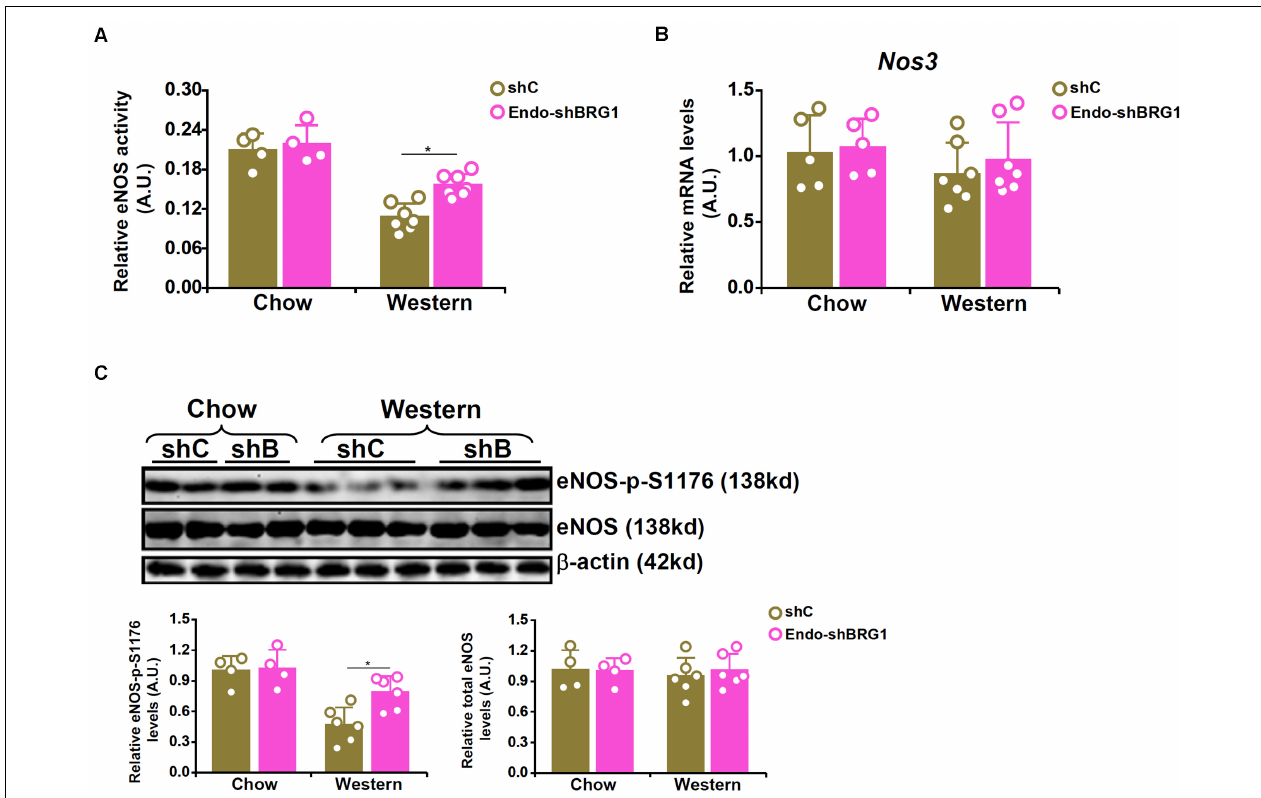
FIGURE 1 | BRG1 regulates NO bioavailability by modulating eNOS phosphorylation in mice. 8-week male Apoe − / − mice were injected with lentivirus carrying endothelial-specific BRG1 shRNA (Endo-shBRG1) or the control virus (shC) and fed a Western diet or a control diet for 8 weeks as described in “Materials and Methods.” (A) Aortic arteries were homogenized and NO content was examined using the Griess assay. (B,C) Gene expression levels in the aortic arteries were examined by qPCR and Western. N = 5 mice for the control diet groups and N = 7 mice for the Western diet groups. * p <